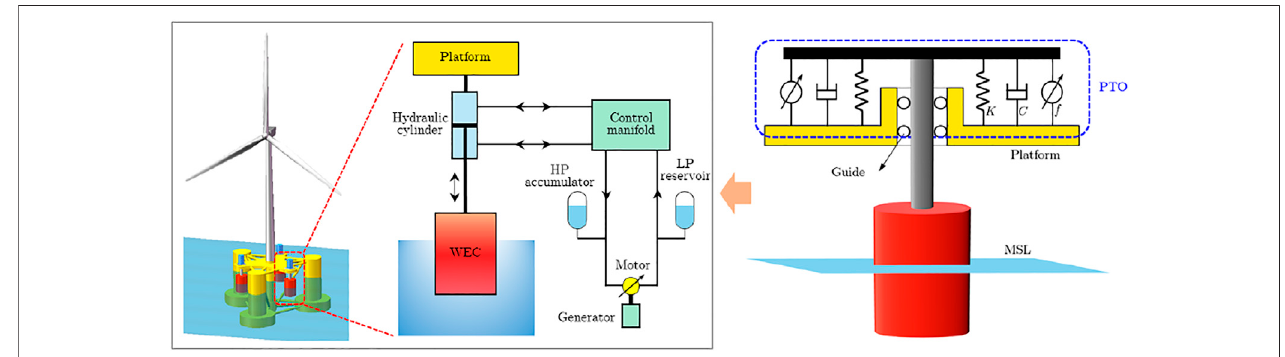
FIGURE 2 | Schematic of the WEC PTO system.